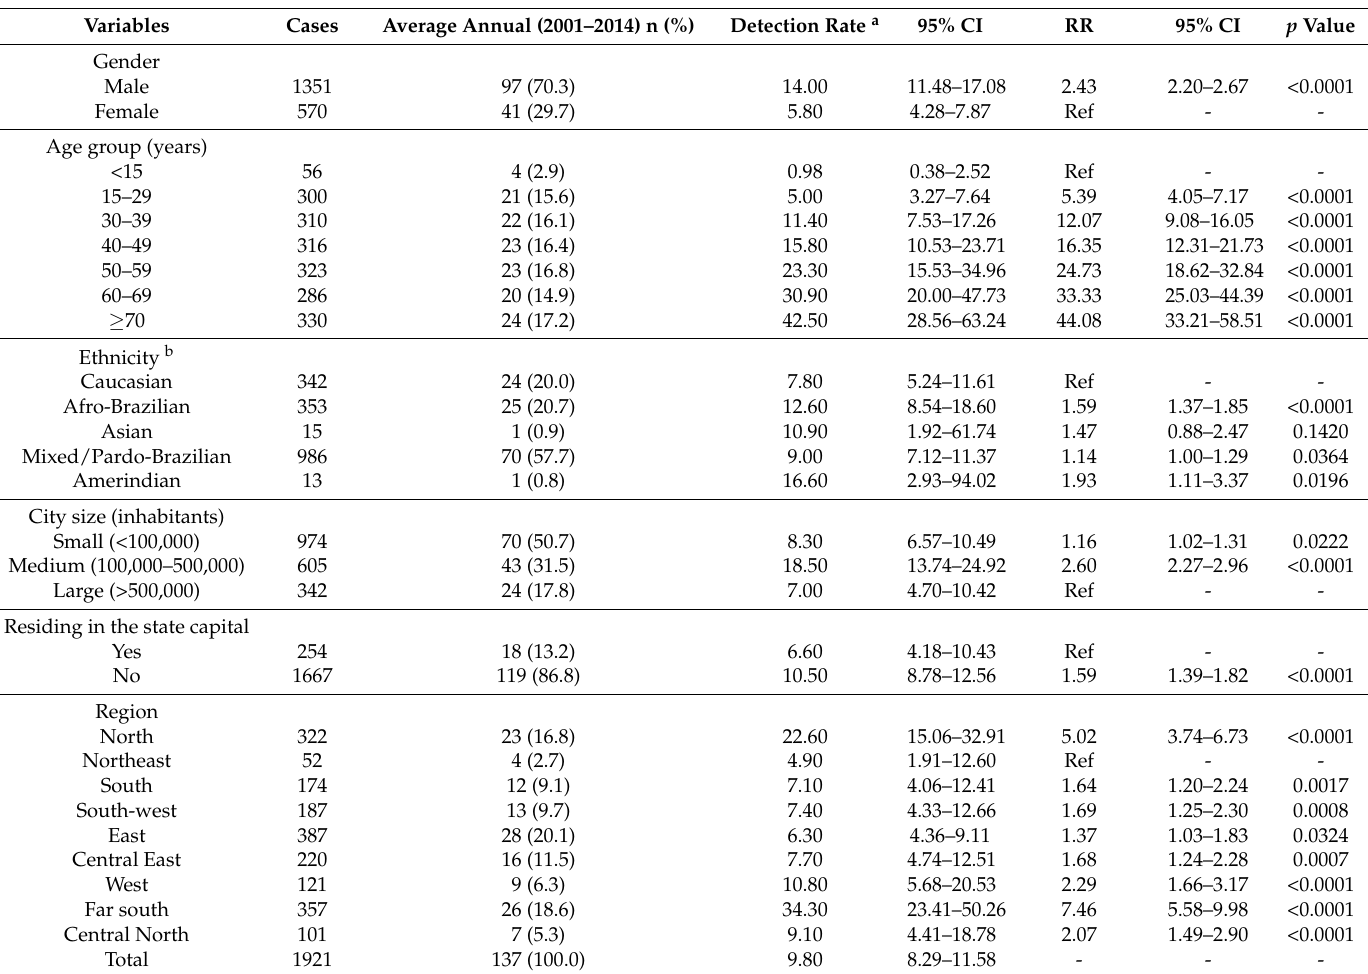
Table 3. Sociodemographic characteristics of leprosy cases with G2D at diagnosis and factors in Bahia state, 2001–2014.